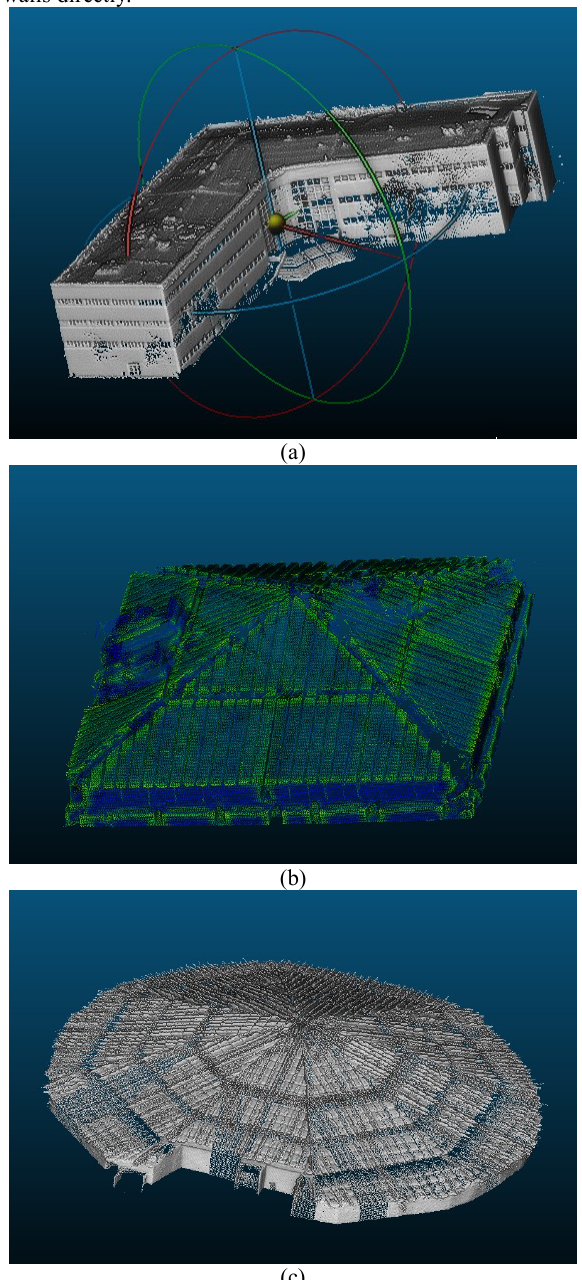
Figure 6. Point clouds of the scenarios: (a) Scenario 1; (b) Scenario 2; (c) Scenario